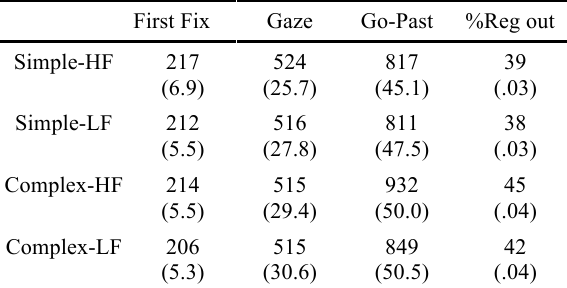
Average eye movement measures on Region 4, the sentence- final region, in milliseconds (standard errors in